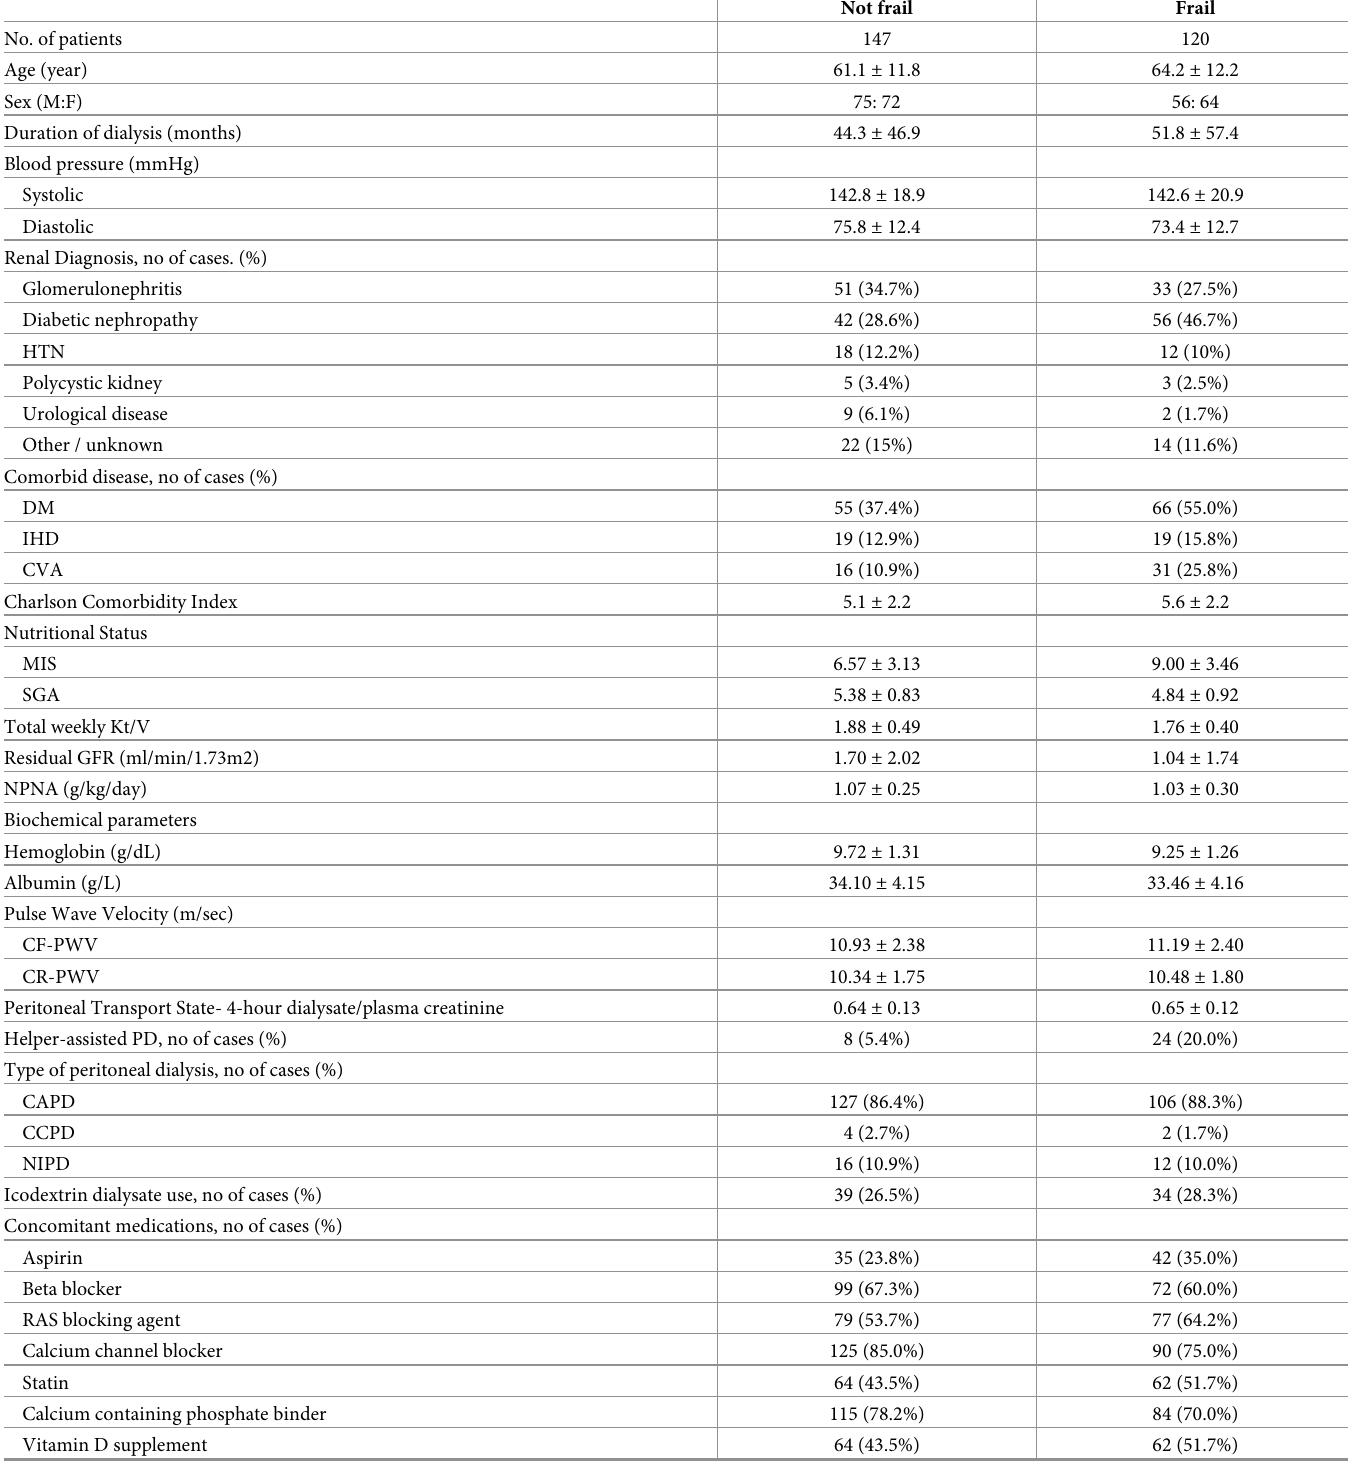
Table 1. Baseline clinical and demographic